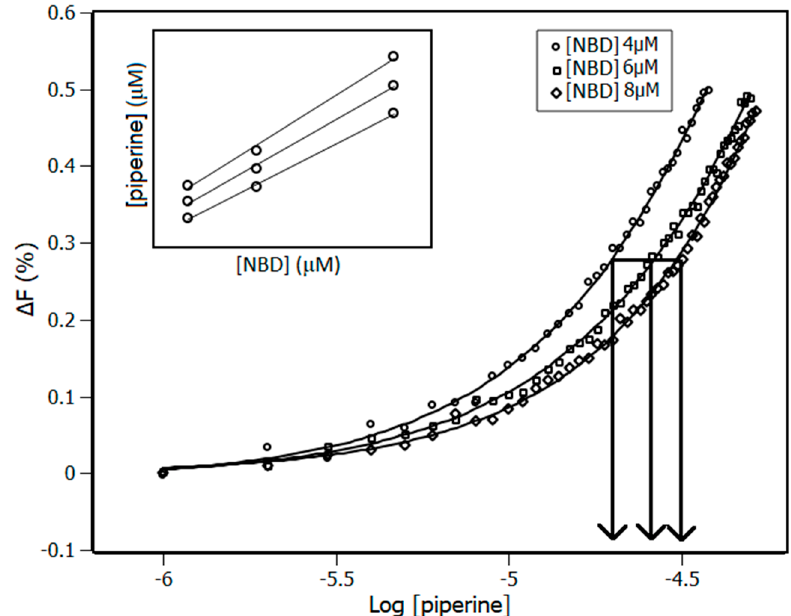
Figure 5. Plot of ∆ F versus the log (piperine) obtained from piperine titration experiments with NBD concentrations of 4 μ M, 6 μ M and 8 μ M at 288 K. The inset contains 3 datasets of (piperine) and (NBD) as an example of using Equation (5) to obtain the values of Σν i and (piperine) free . Free ligand concentration and the average interaction density are related to each other through the expression of mass conservation (Equation (10)).